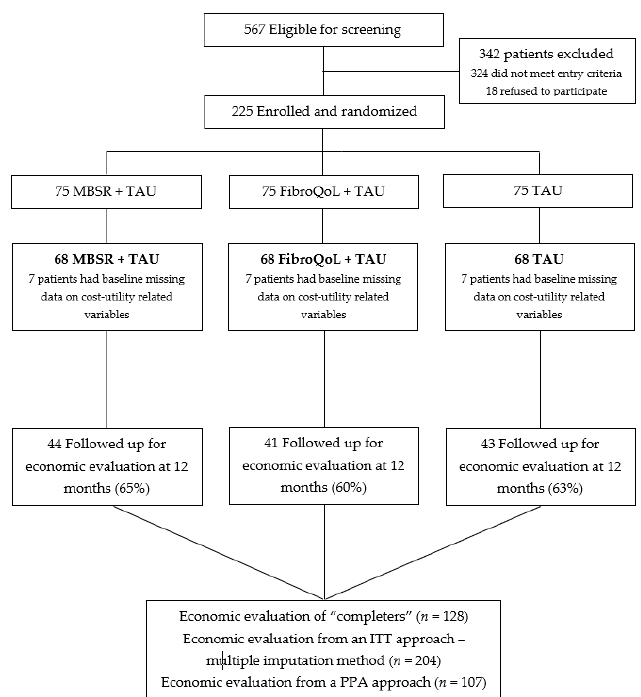
Figure 1. Trial flow chart describing the recruitment process of all three study arms. Note: MBSR = Mindfulness-Based Stress Reduction; TAU = Treatment-as-usual; ITT = intention-to-treat; PPA = Per protocol analysis.